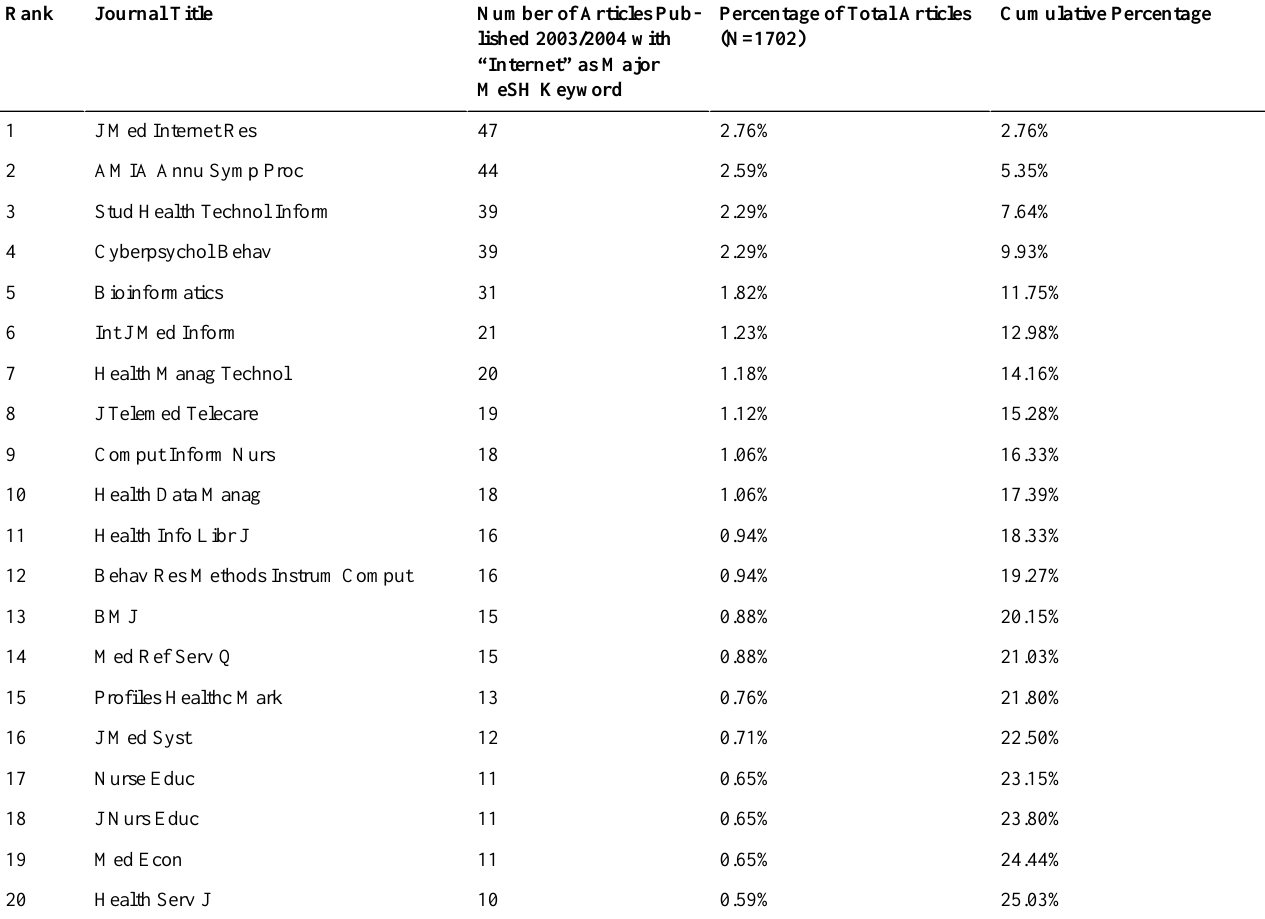
Table 1. Distribution of articles published 2003/2004 and Medline-indexed with the keyword “Internet” as major MeSH (Medical Subject Heading) among the top 20 journals (a total of N=1702 papers were scattered in 685 different journals, not all shown